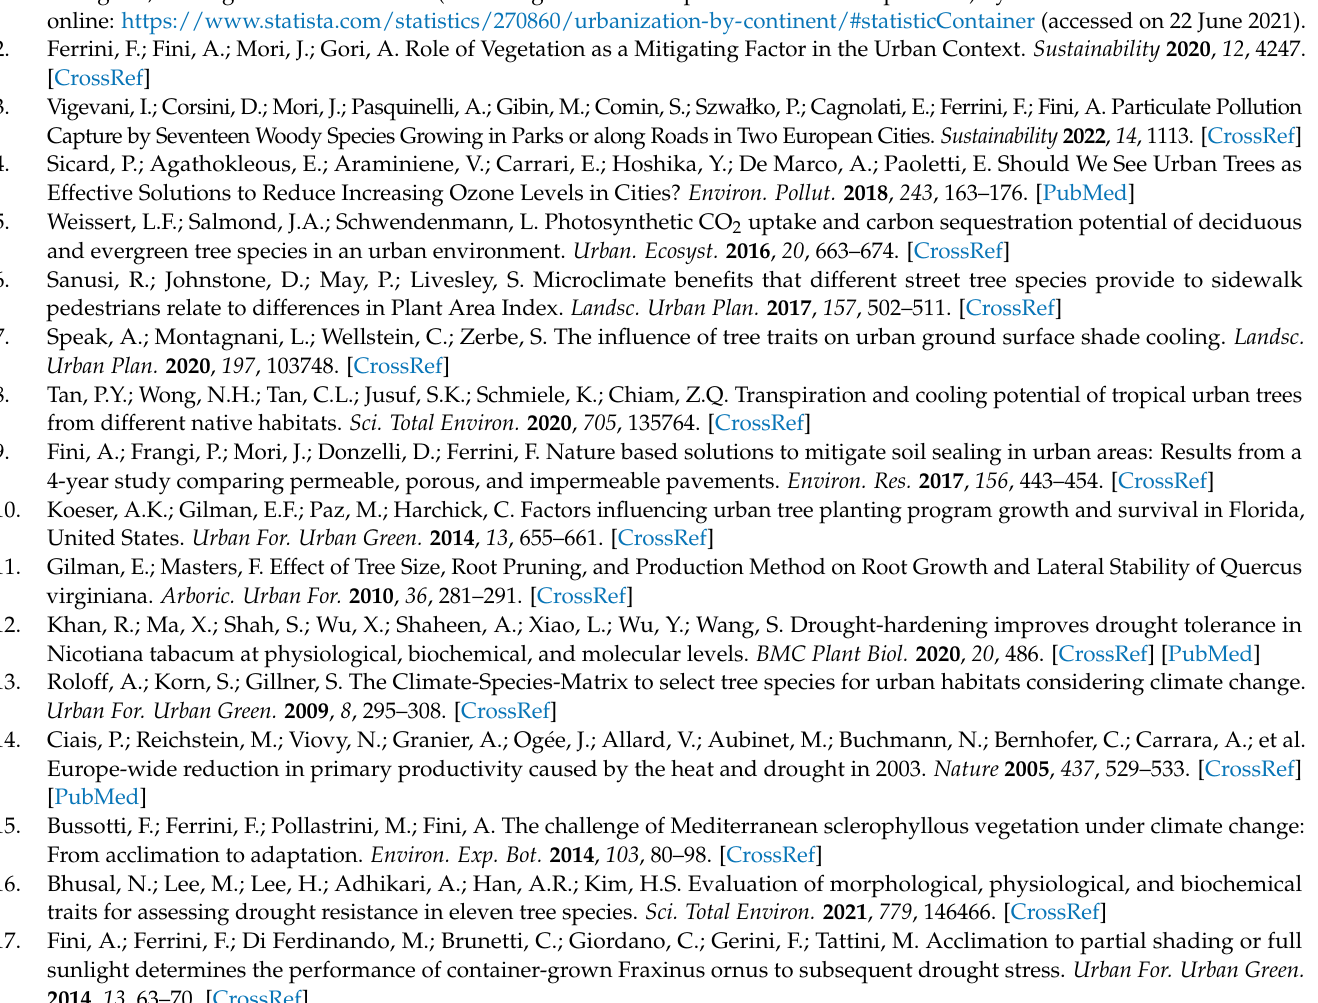
Figure A2. Microscope images of mycorrhizal symbioses: ( a ) fungal mantle of ECM in Tilia cordata Mill. observed at 400× magnification (dashed line); ( b ) ECM (dashed line) and AMF (solid line) in Tilia cordata observed at 100× magnification; ( c ) arbuscular structure (solid line, left) and fungal hyphae (solid line, right) of AMF in Acer campestre L. observed at 1000× magnification.